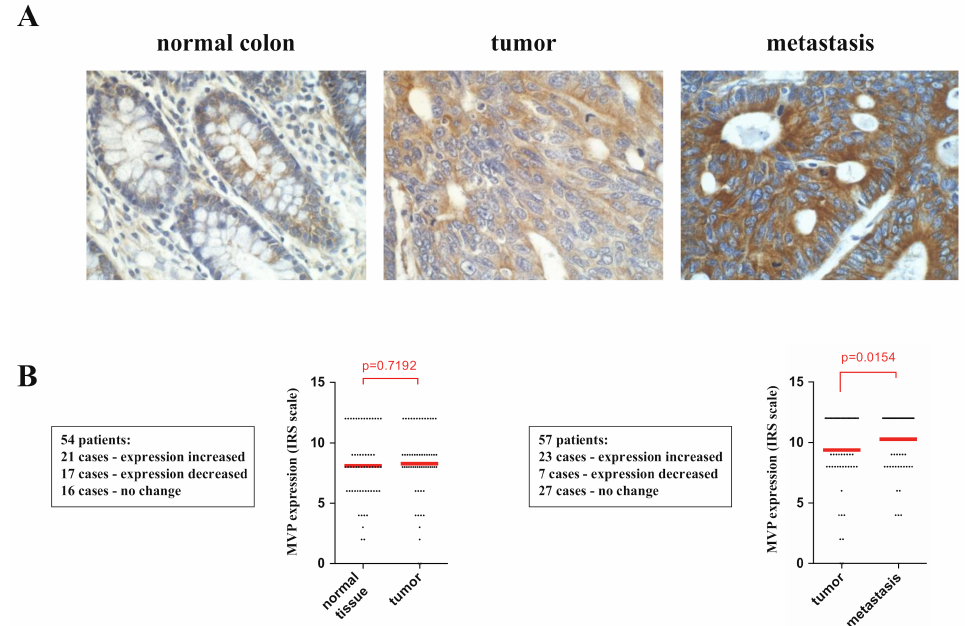
Figure 1. Comparative evaluation of MVP immunohistochemical (IHC) expression in tissue samples of normal colon, colorectal cancer and lymph node metastasis using immunoreactive score (IRS). ( A ) Representative images of the IHC detection of MVP in the normal human colon mucosa, primary tumor and lymph node metastasis in the same patient; note the predominantly cytoplasmic expression pattern of MVP and the most intense IHC reaction in tumor metastasis. Hematoxylin counterstained. 40 × objective. ( B ) The comparison of mean MVP expression—left graph: comparison normal tissue—primary tumor and right graph: comparison primary tumor—tumor metastasis (red line–average). The cages show information on the number of patients and information on the increase, decrease and no change in